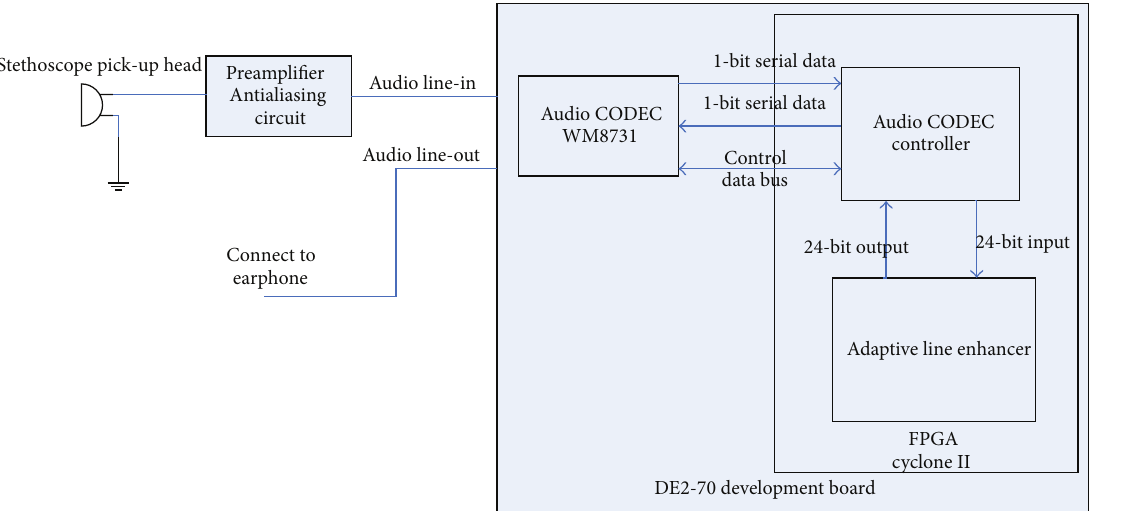
Figure 1: Proposed prototype block